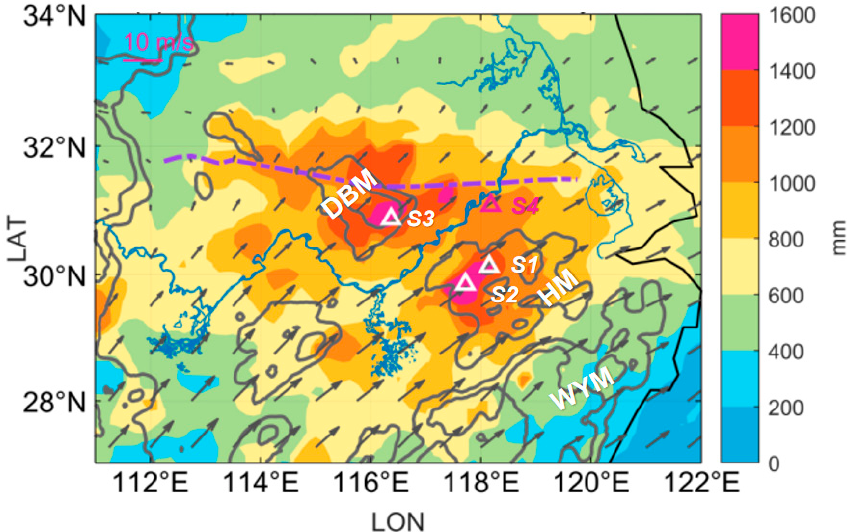
Figure 1. The accumulated rainfall (mm; shadings) from national rain gauges over YHRB and 850 hPa mean wind vectors from ERA5 (full data description in Section 2.1). The location of national rain gauges receiving an accumulated rainfall of over 1500 mm in June–July 2020 are marked by white triangles (S1: 1719.5 mm; S2: 1667.5 mm; S3: 1581.6 mm). The locations of national rain gauges that recorded maximum hourly rain rates (S4) during June–July 2020 are marked by red triangles. The Dabie, Huang, and Wuyi mountains are labeled by the abbreviations DBM, HM, WYM, respectively. The thick purple dash-dotted line denotes the distribution of the mean Meiyu front in June–July 2020, determined by the maximum gradient of the equivalent potential temperature at 850 hPa from ERA5. The gray contours show terrain heights at altitudes of 250 m and 500 m.